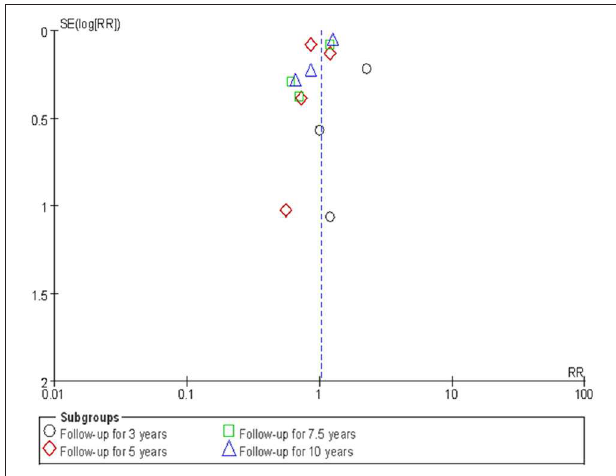
FIGURE 6 | Publication